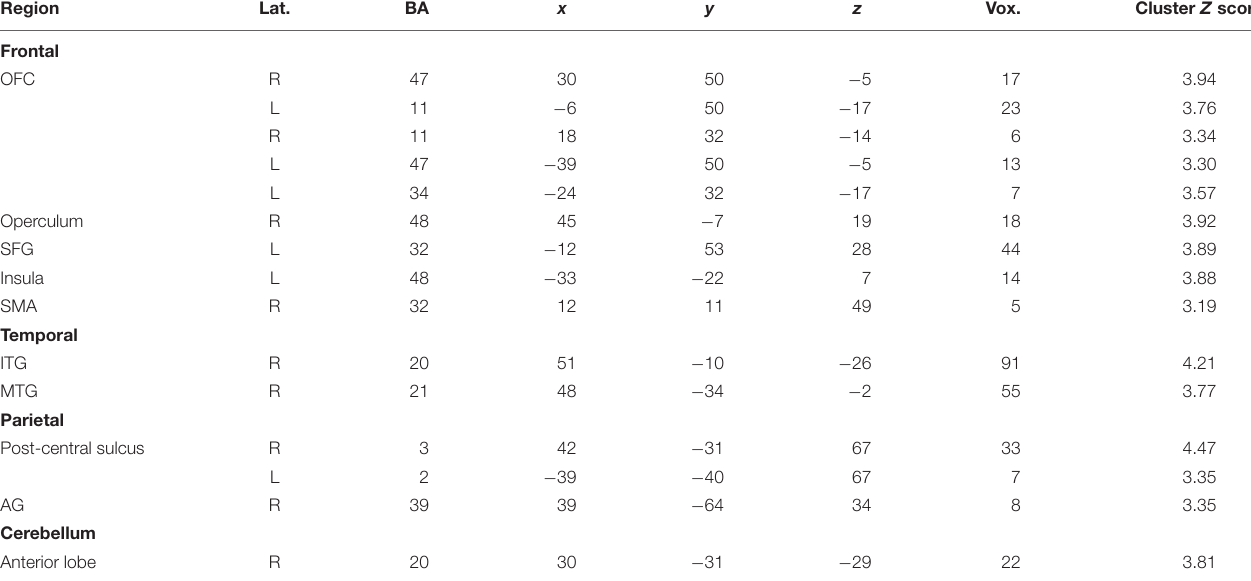
TABLE 3 | Minor clusters activated during the think vs. no-think1 contrast. Region Lat.